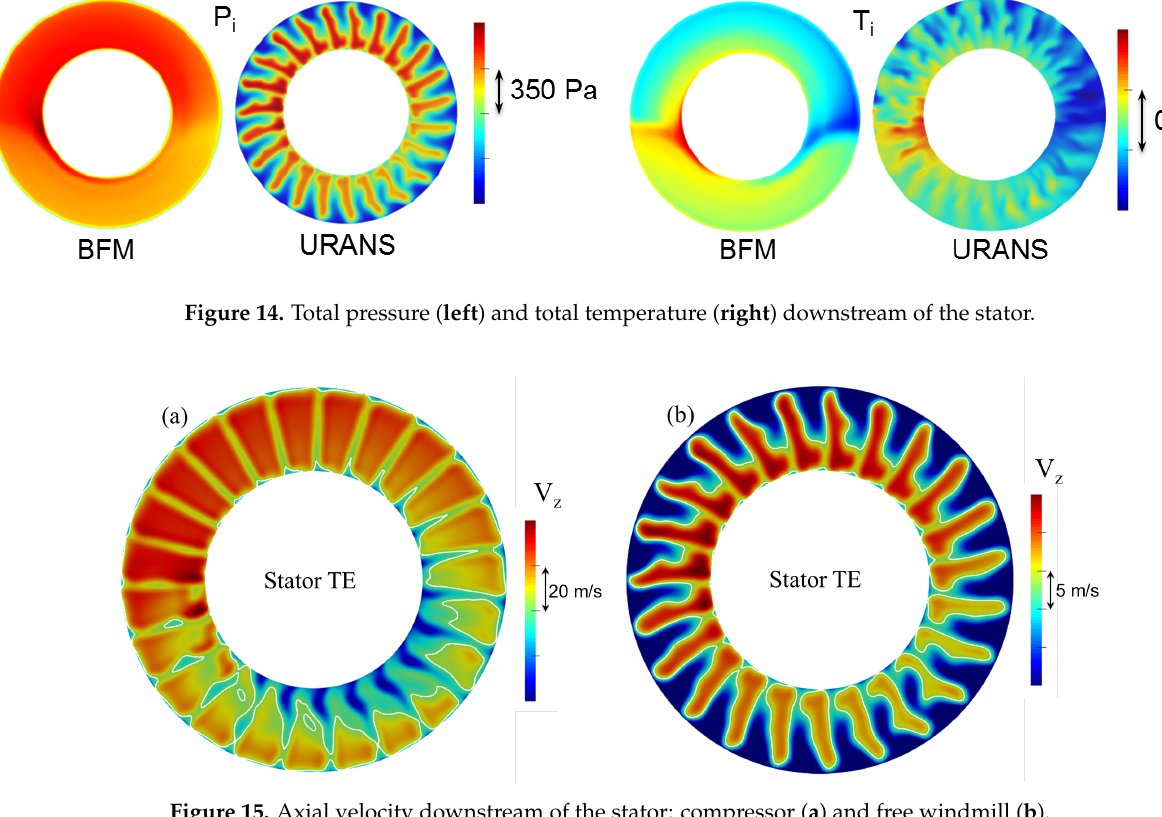
Figure 15. Axial velocity downstream of the stator: compressor ( a ) and free windmill ( b